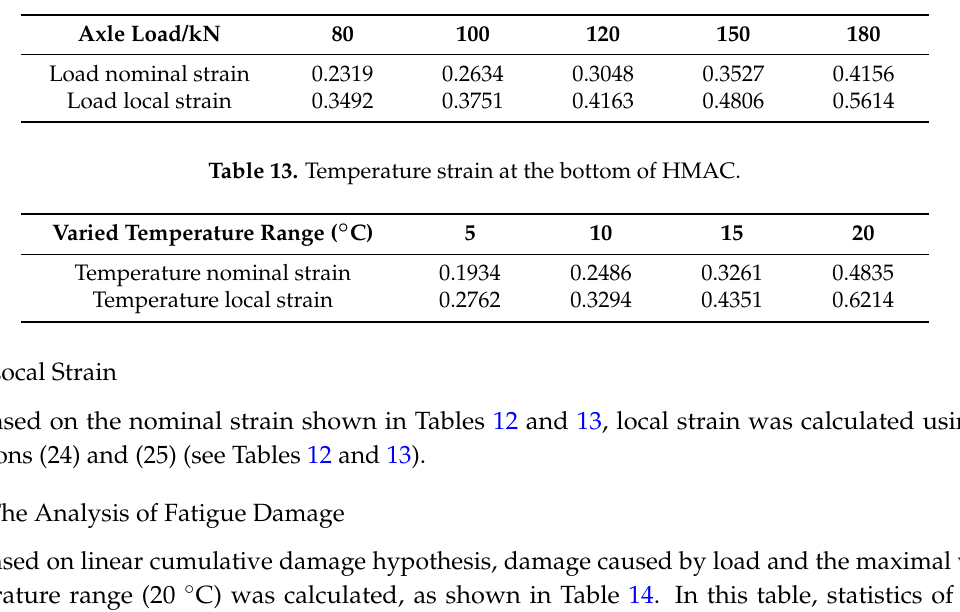
Table 12. Load strain at the bottom of HMAC.